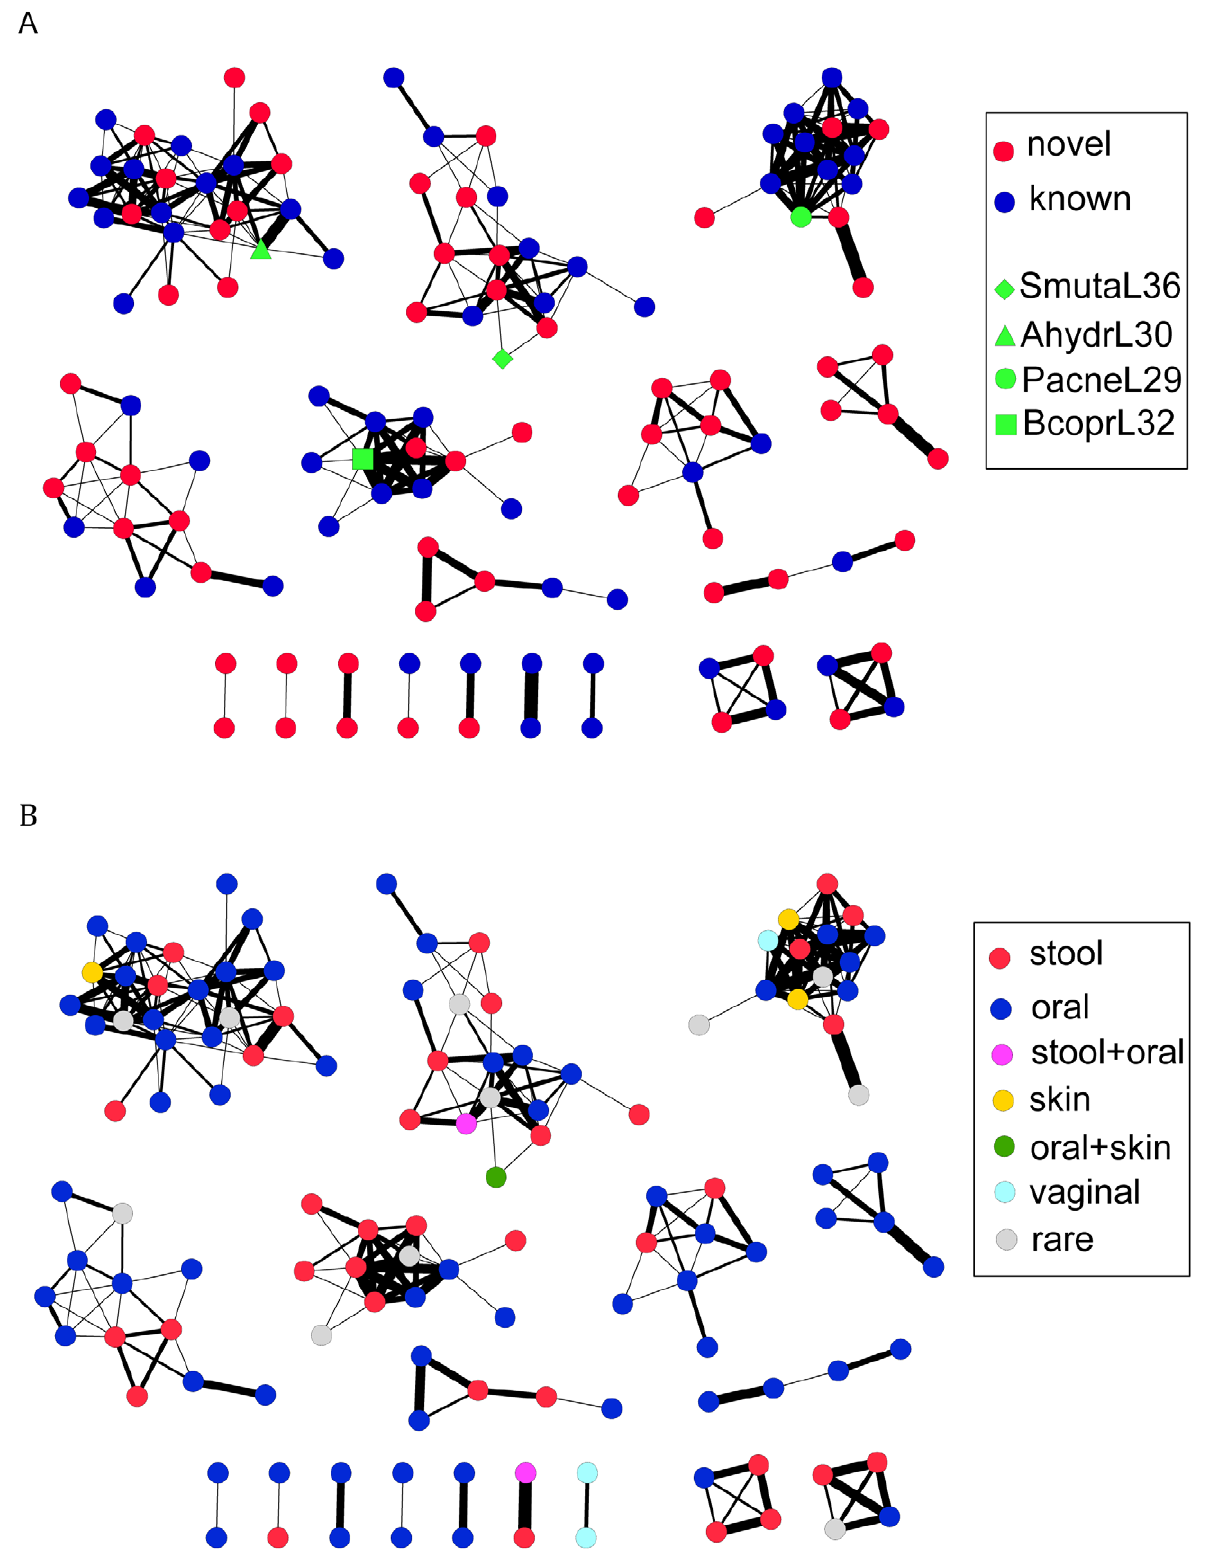
Figure 3. Visualizations of the CRISPR network of 150 CRISPRs, each represented as a node. There is an edge between two nodes, if the edit distance between the consensus sequences of the repeats of the corresponding CRISPRs is , 10, with edges of small edit distances ( i.e. , the two CRISPRs share more similar repeats) shown in thick lines and edges of larger edit distances in thin lines. In (A), the known CRISPRs are shown as blue nodes (except for several CRISPRs highlighted in green), and the novel CRISPRs identified in the HMP datasets are shown as red nodes. In (B), the